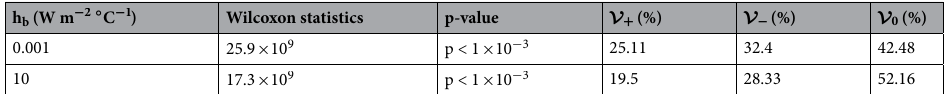
Table 3. Statistical significance of Fig. 11. Parameter V + represents percentage of domain volume that has (cid:31) T ≥ 1 ◦ C. Parameter V − represents percentage of domain volume that has (cid:31) T ≤ − 1 ◦ C. Parameter V 0 represents percentage of domain volume that has − 1 ◦ C < � T < 1 ◦